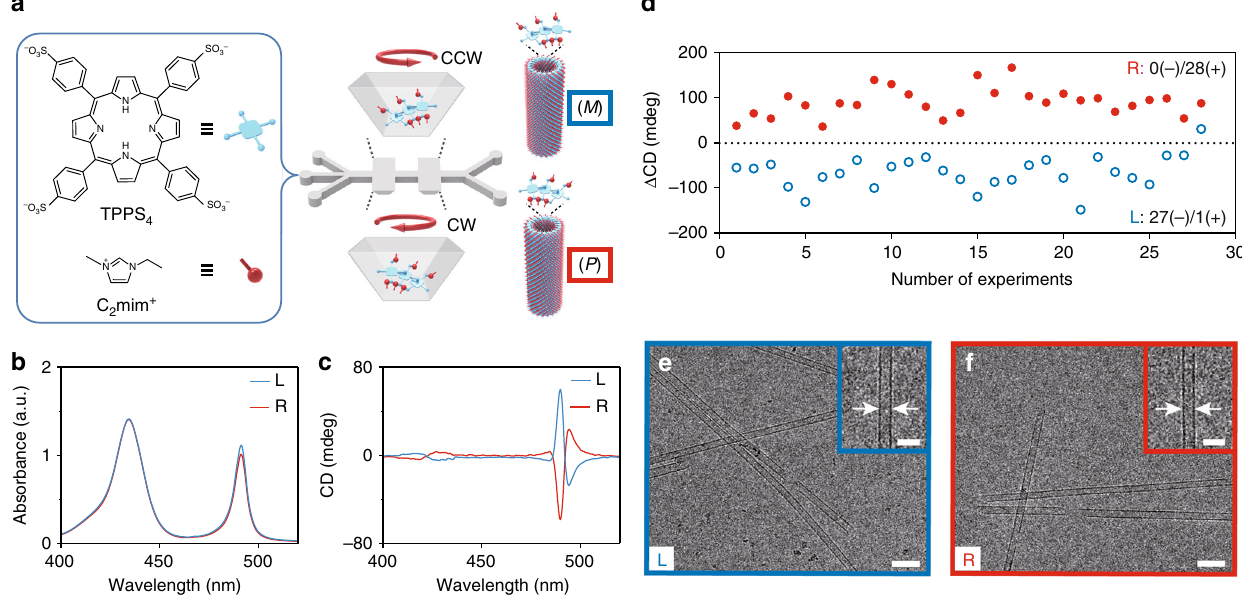
Fig. 3 TPPS 4 J-aggregates with opposite chirality signs selected by microvortices. a Formation of chiral supramolecular nanotubes by the self-assembly of achiral TPPS 4 building blocks (blue) and the C 2 mim + ionic stabilizer (red) within the microvortices. b UV-Vis spectra exhibit a monomer peak at 433 nm and a J-aggregate peak at 491 nm for TPPS 4 assemblies from the L- (blue line) and R-outlet (red line). c CD spectra indicate opposite chirality of the TPPS 4 assemblies from the L- (blue line) and R-outlet (red line). d CD signals of 28 independent experiments reveal nearly absolute chirality control over supramolecular TPPS 4 assemblies from the L- (void blue circles) and R-outlet (solid red circles). e , f Cryo-EM examinations of TPPS 4 aggregates from the L- and R-outlet show the hollow tubular nanostructures with an average diameter of 12.8 ± 0.1 nm (mean ± s.e.m.; n = 40). Scale bars, 50 nm. The insets are the enlarged cryo-EM images. Scale bars in the insets, 20